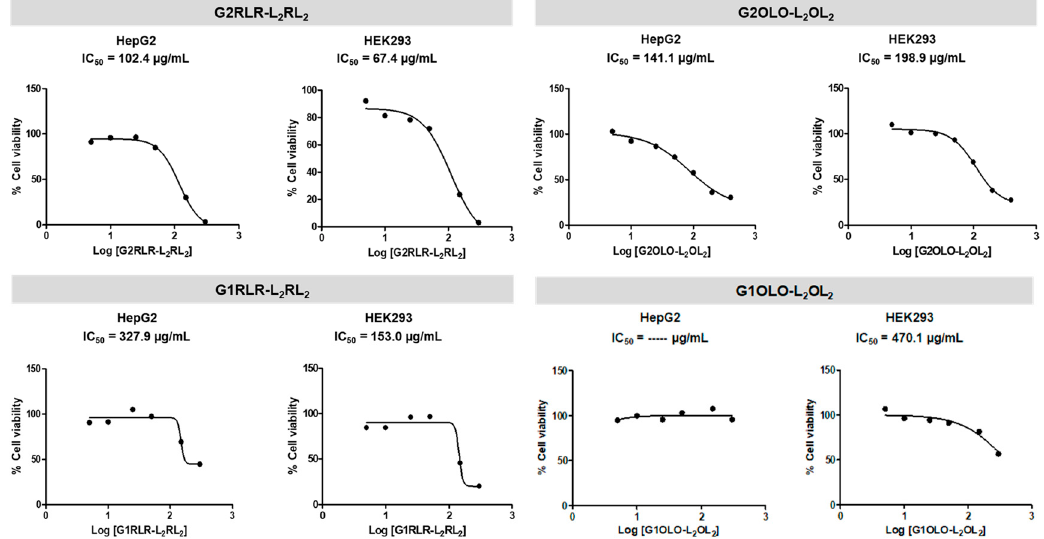
Figure 3. Cytotoxicity of G2RLR-L 2 RL 2 , G2OLO-L 2 OL 2 , G1RLR-L 2 RL 2 and G1OLO-L 2 OL 2 in HepG2 and HEK293 cell lines.